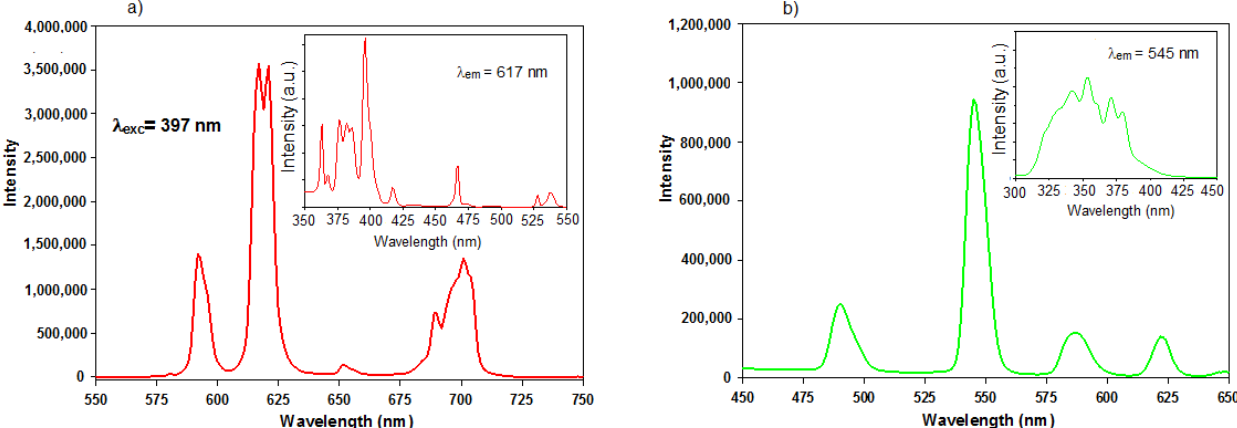
Figure 9. The emission luminescence spectra for complexes 3 ( a ) and 4 ( b ). The excitation spectra of complexes were inserted in the inset of emission spectra.